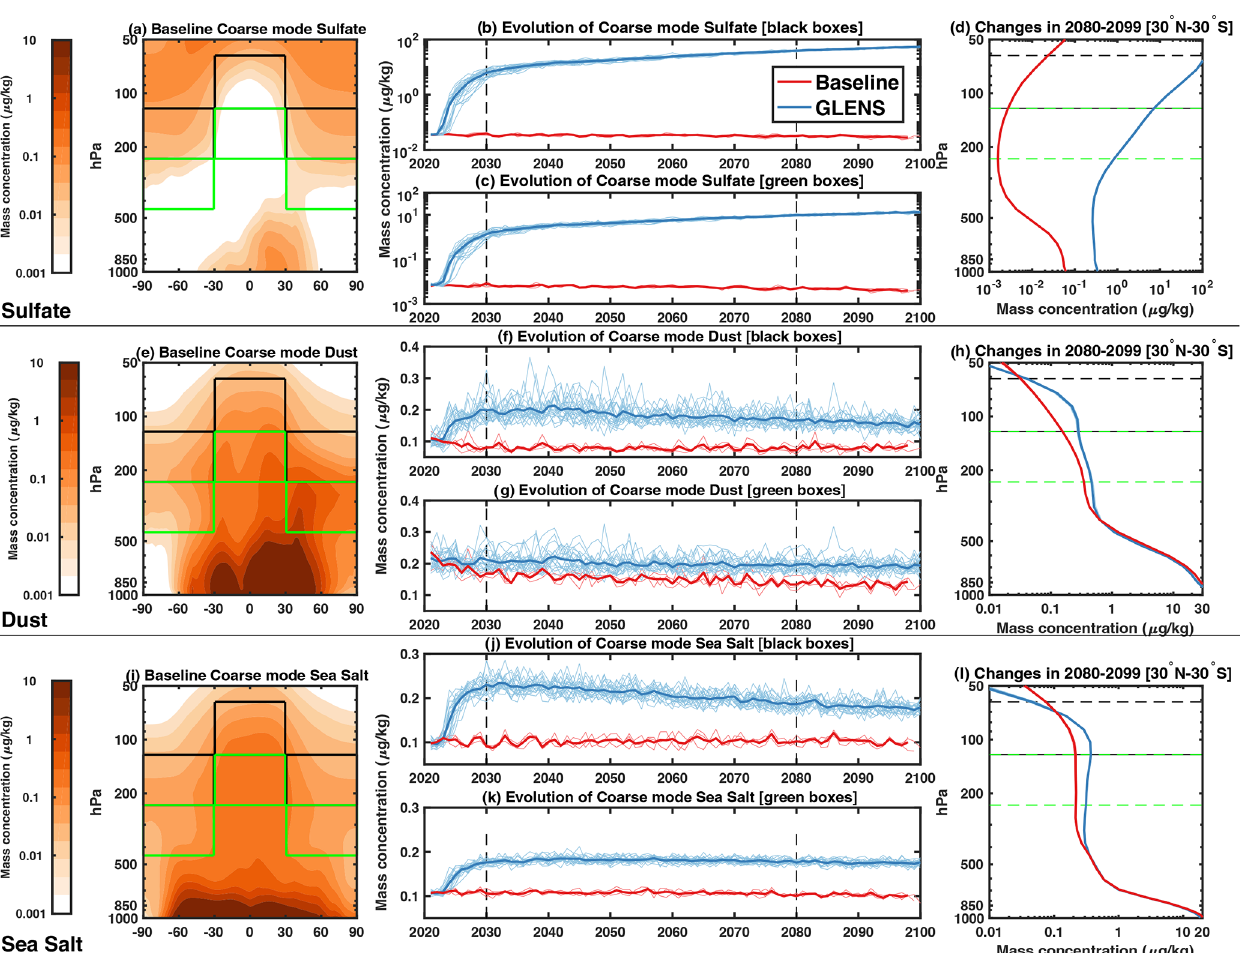
Figure 1. Mass concentration (in micrograms per kilogram of air) of coarse mode species (sulfate, top row; dust, middle row; and sea salt, bottom row). On the left, panels (a) , (e) and (i) indicate the Baseline (2020–2029) zonal mean concentration for the respective species, with the black and green boxes indicating the areas considered in the averages for the central panels (b, c, f, g, i, k) . The uppermost limit of the green boxes and the lowermost limit of the black boxes coincide. Panels (b) , (f) , (j) and (c) , (g) and (k) for each species show the annual evolution of the concentration in the black (b, f, j) and green (c, g, k) boxes, with thinner lines showing the single ensemble realizations, and the thicker lines show the ensemble mean; red lines indicate the Baseline simulations, while blue lines indicate the GLENS simulations. Black dashed lines in panels (b) , (f) , (j) and (c) , (g) and (k) indicate the periods of analysis for panels (a) , (e) , (i) and (d) , (h) and (l) , respectively. On the right, panels (d) , (h) and (l) show the vertical profiles in both cases (Baseline in red, and GLENS in blue) for the period 2080–2099. The black lines in panels (d) , (h) and (l) indicate the altitude of analysis in panels (b) , (f) and (j) , while the green lines indicate the altitude of analysis in panels (c) , (g) and (k)